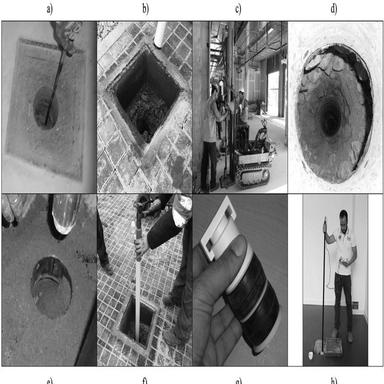
Installation procedure of the access tubes. (a) Manhole on the floor of one of the buildings. (b) Manholes in the perimeter development. (c) Drilling machine used to construct the boreholes. (d) Borehole. (e) Filling of a borehole with fine sand. (f) Access tube installation. (g) Expandable bung. (h) Reading taken in a profile.